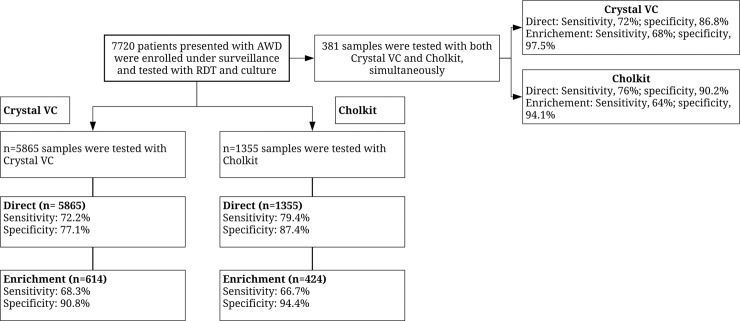
Flow of study participants.